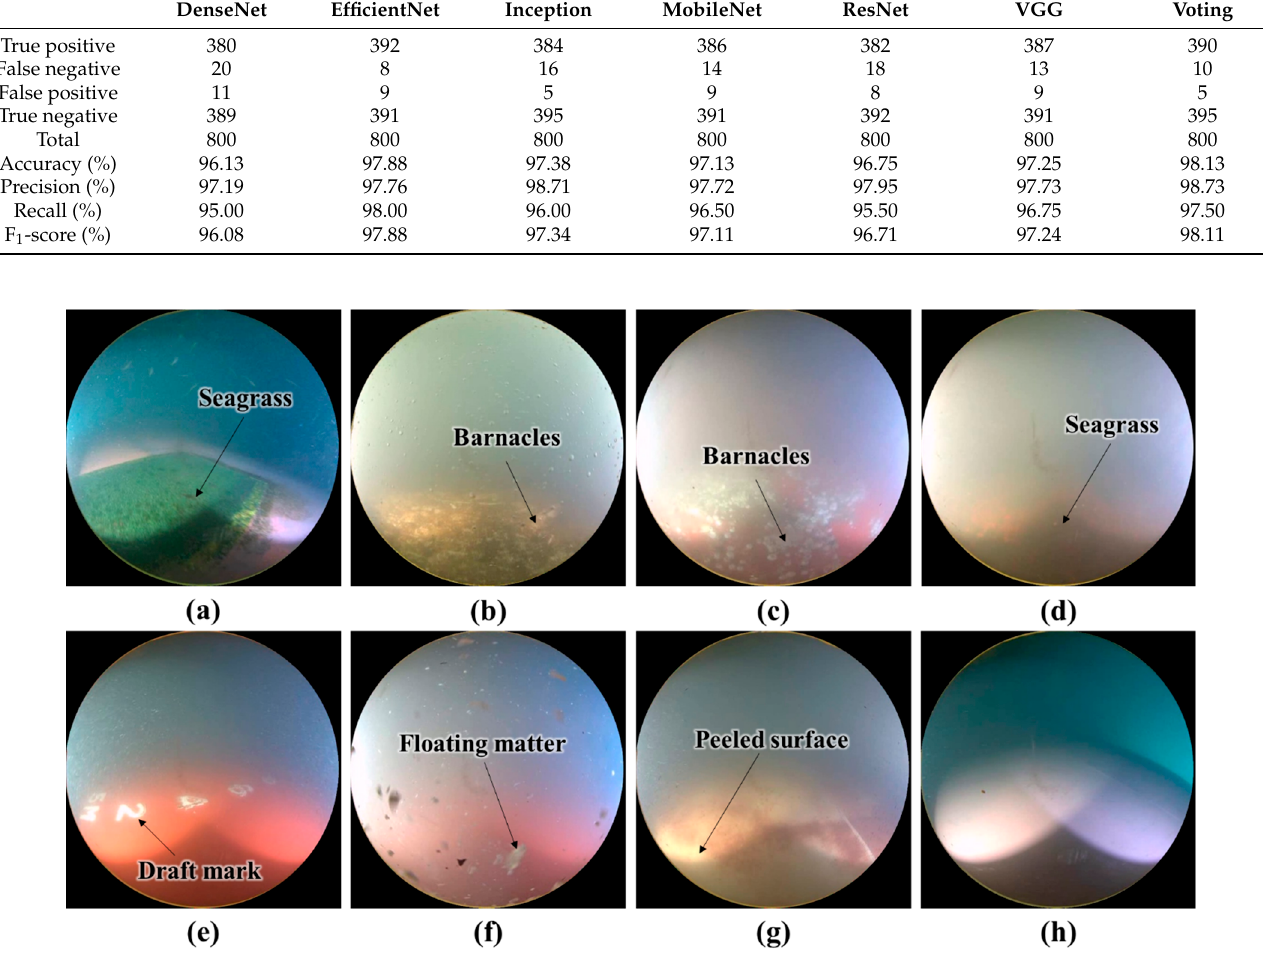
Figure 6. Examples of classified images with the soft voting ensemble: ( a – d ) images classified as